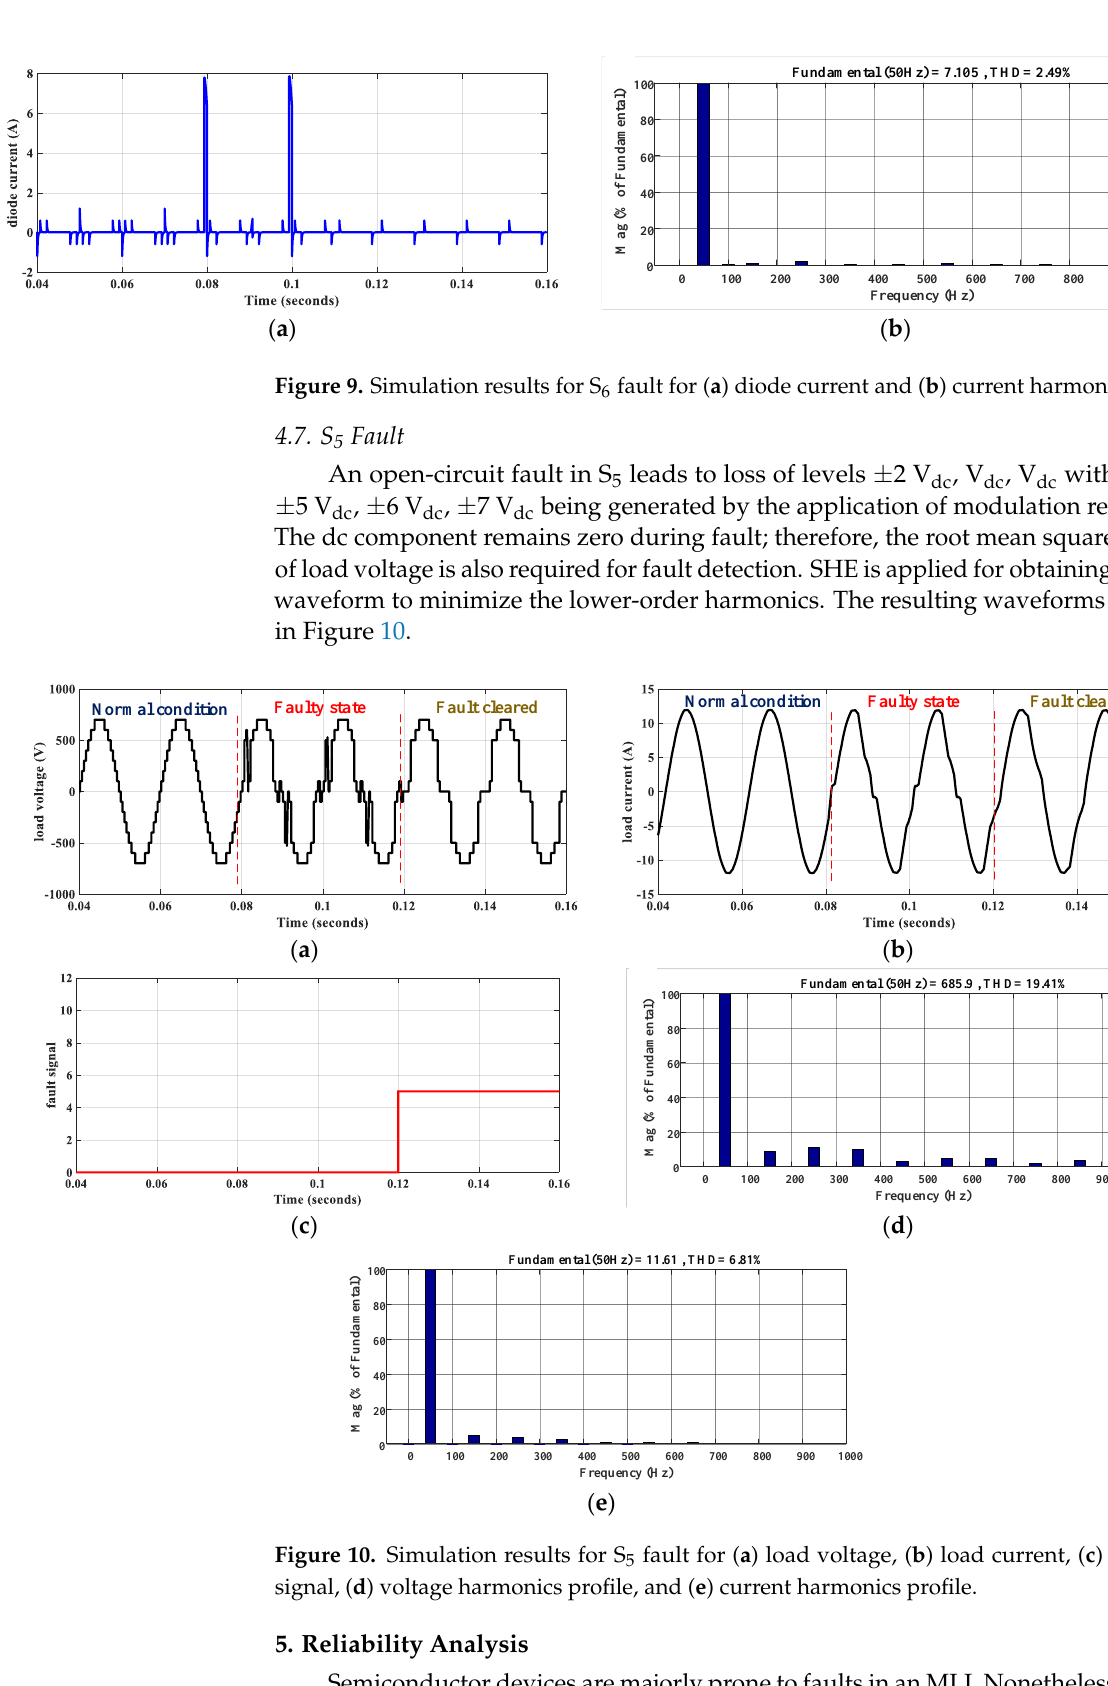
Figure 8. Simulation results for S 6 fault for ( a ) load voltage, ( b ) load current, ( c ) fault detection signal, and ( d ) voltage harmonics profile.